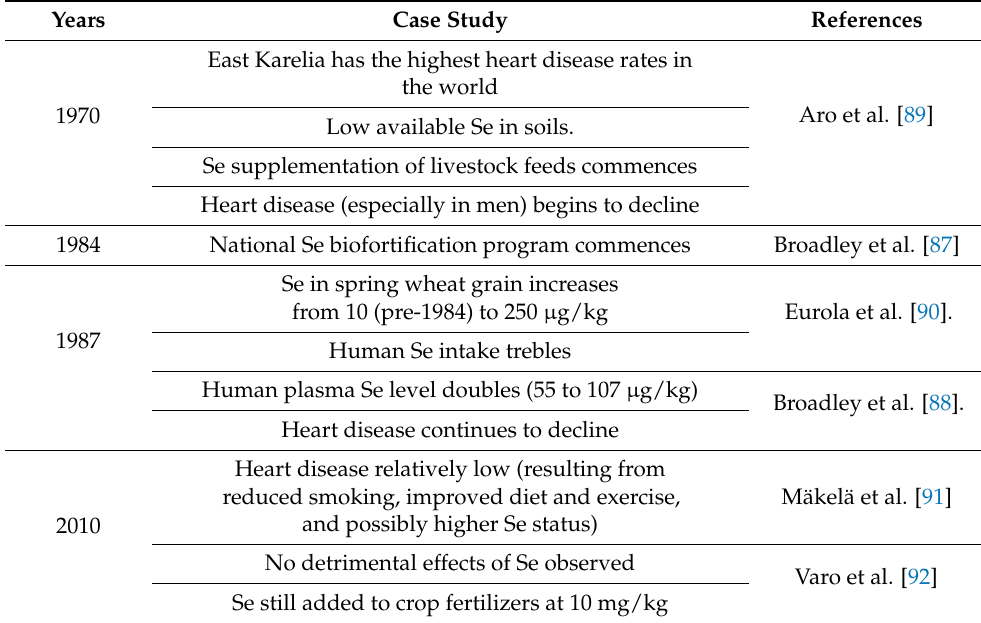
Table 3. Results of a Se-biofortification program in